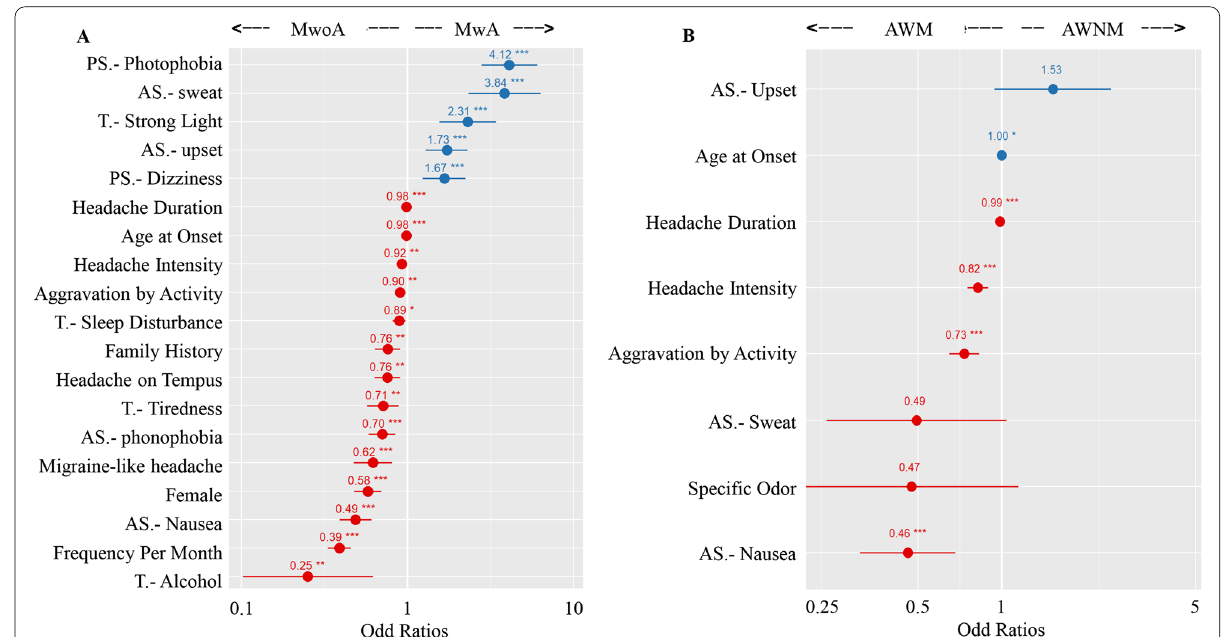
Fig. 7 Forest plot of characteristics of migraine that distinguish MwoA and MwA ( A ), AWM and AWNM ( B ). Variable-specific odds ratios (95% confidence intervals) are denoted by dots (lines). The detailed results of the binary logistical regression model can be found in Supplementary Tables 6 and 7. * P -value < 0.05, ** P -value < 0.01, *** P -value <